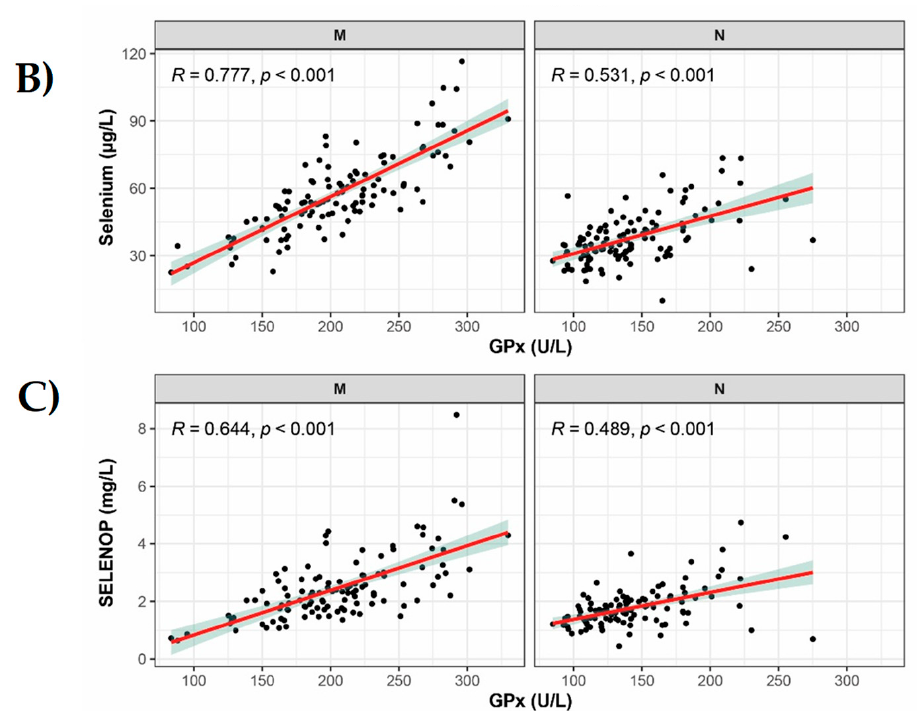
Figure 2. Correlation analysis of Se status biomarkers in the mothers and the newborns. Significant positive correlations were observed for all three biomarkers in all possible combinations, both in the full cohort of samples as well as in the groups of mothers (M, left panel) and newborns (N, right panel) separately. The linear positive correlation of ( A ) Se with SELENOP was most pronounced and stringent, in particular in newborns. ( B ) Serum Se and GPX3 activity correlated to a similar extent as ( C ) SELENOP and GPX3 activity. Correlation analyses conducted by Spearman’s R test; linear regression results are indicated as red lines with the 95% confidence intervals as green shadows.